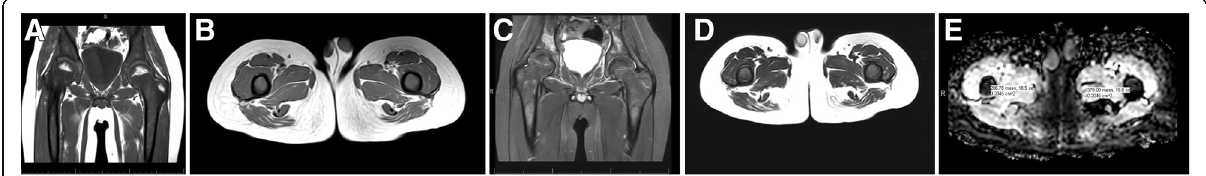
Fig. 2 A 12-year-old male with known ALL. MRI of the pelvis showed diffuse marrow infiltration of the pelvic bones and upper femora. The lesion appeared as diffuse abnormal marrow signal eliciting low T1 ( a , b ), intermediate T2 and STIR signal ( c and d , respectively) with low signal on ADC map ( e ). ADC values were 0.206 × 10 − 3 mm 2 /s and 0.379 × 10 − 3 mm 2 /s in the right and left femur,